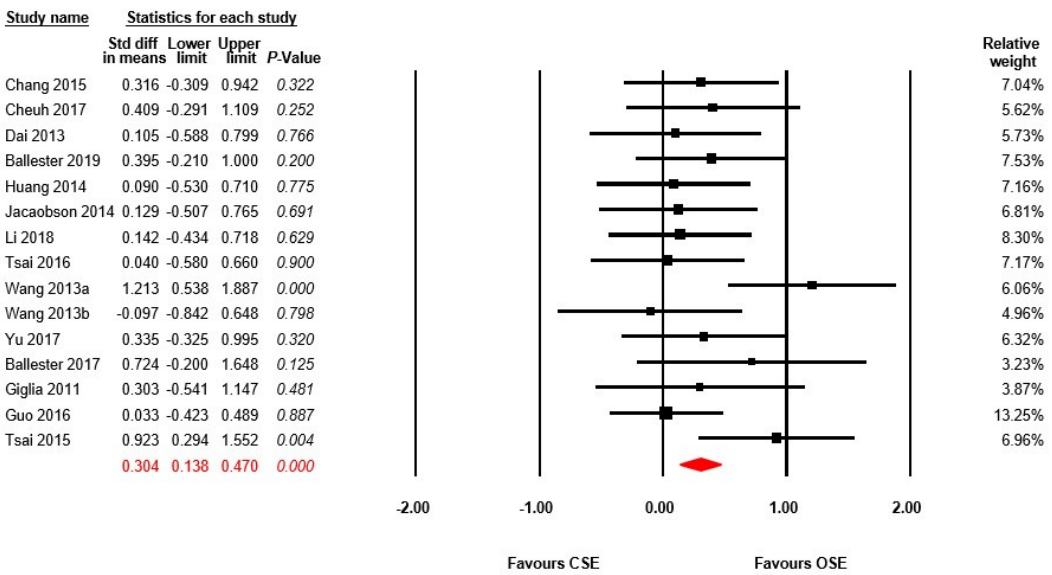
Figure 2. Forest plot for the e ffi cacy of OSE compared to CSE in cross-sectional